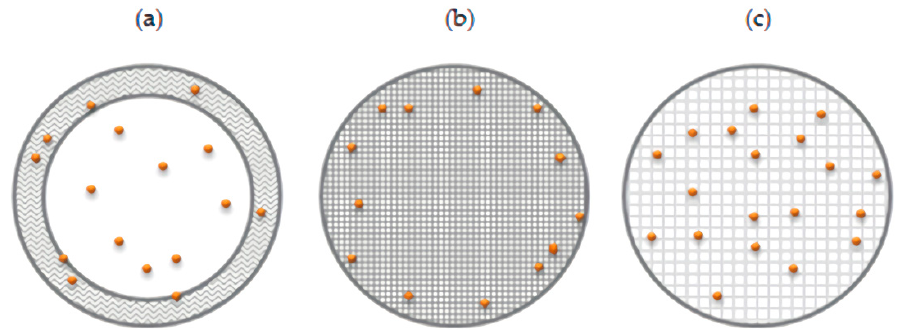
Figure 6. Schematic representation of proposed microparticle structures and BSA (orange dots) loading patterns: microparticles with core–shell structure ( a ), microparticles possessing a high degree of cross-linking of the polymer matrix ( b ), and microparticles possessing a lower degree of cross-linking of the polymer matrix ( c ).